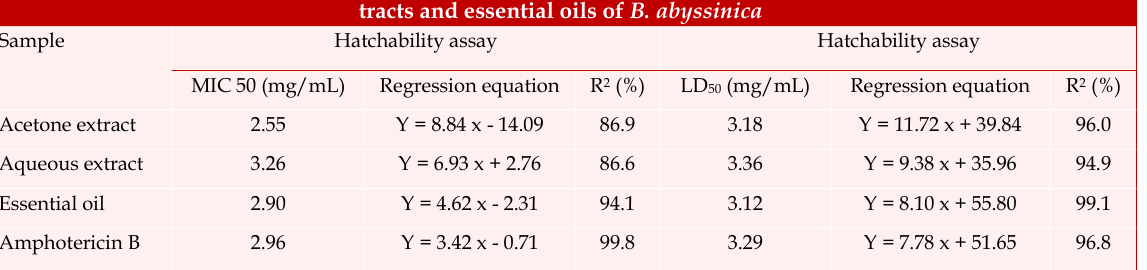
Hatchability and lethality of A. salina incubated in different concentrations of acetone extract, aqueous ex- tracts and essential oils of B.